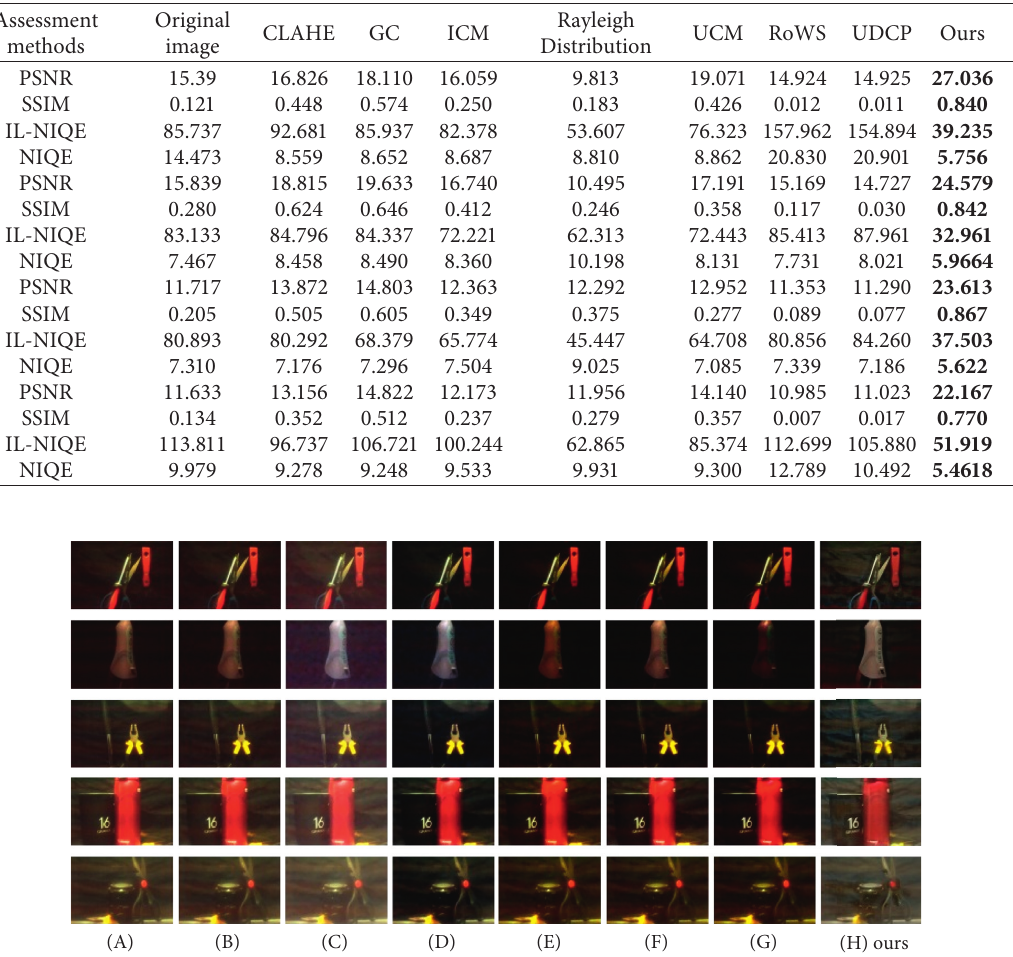
Figure 10: The testing comparison between our algorithm and S+D +underwater enhancement and restoration algorithms. The columns from A to G, respectively, mean the pipeline: luminosity scaling (A), luminosity scaling +denoising algorithm (B), S+D +GC (C),